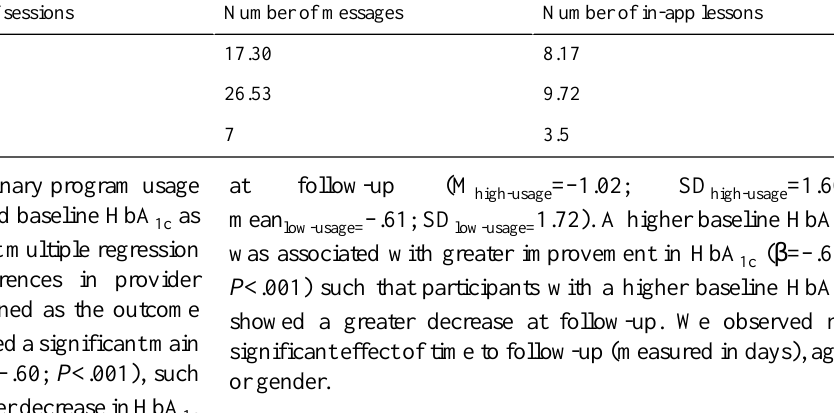
Number of in-app lessonsNumber of messagesNumber of